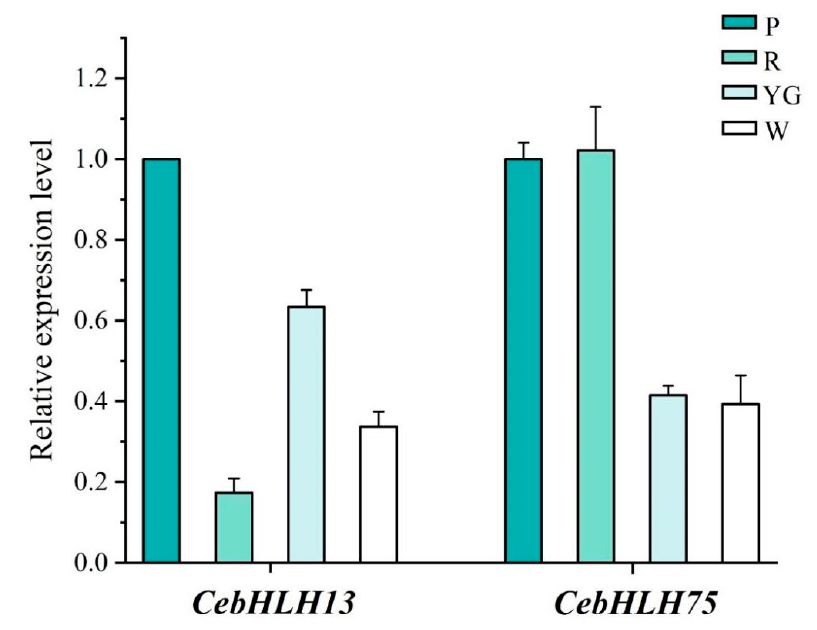
Figure 8. qRT-PCR Analysis of CebHLH13 and CebHLH75 . P stands for purple-red sepals; R stands for red sepals; YG stands for yellow-green sepals; W stands for white sepals.